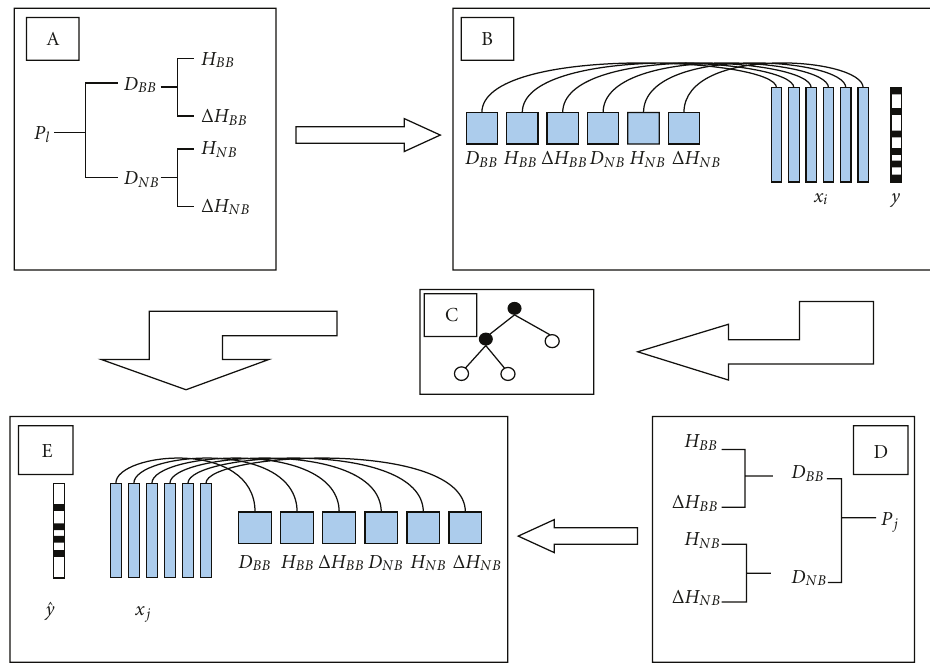
Figure 1: The Statistical (A, D) and Morphological (B, C, E) Data Processing Flow. A—Spectrograms { P 1 , ... , P k } are a subject to MMD test, the ouptut of which D NB and D BB are used for estimation of entropy H and di ff erence of entropies Δ H ; B—The images of features (filled squares) are used to form X = ( x 1 , ... , x n ) T . The feature vectors x corresponding to SI are labeled by y = 1 and by y = 0 in the opposite case; C—mask of signal of interest in a form of GP tree; D—statistical processing of a test spectrogram P j ; E—features estimated in D are used for testing the masking algorithm C .